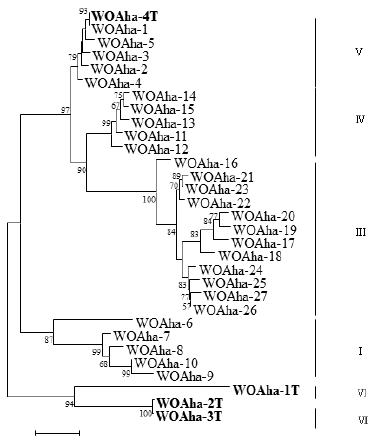
Figure 1. Maximum likelihood tree for phage WO types of A. hakonensis based on full length of orf7 sequences. The numbers in parentheses indicate the number of sequences obtained. WOS-xT refers to the serial number. Phage WO types are shown on the right. Numbers above and below branches are bootstrap values computed from 1000 replications.